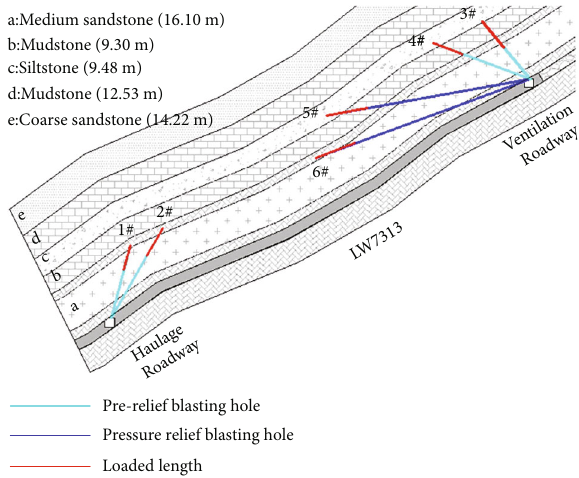
Figure 17: Layout of pressure relief